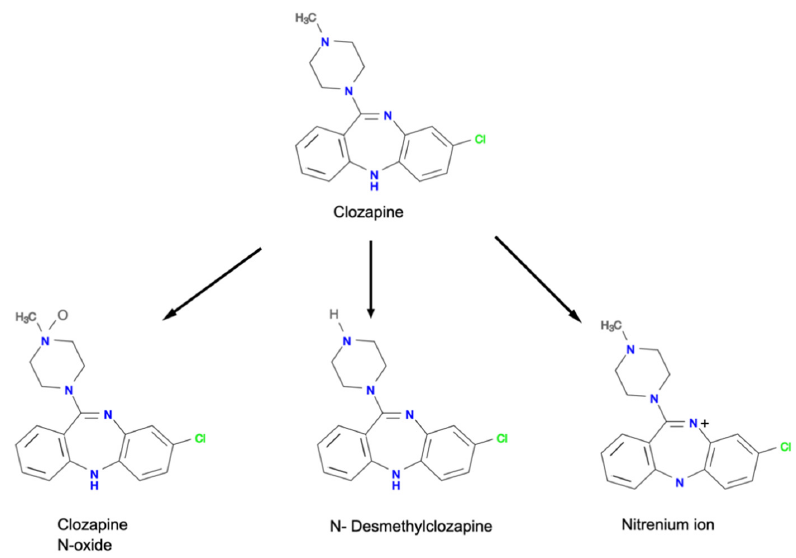
Figure 3. Chemical structures of clozapine and nitrenium ion (adapted from Pirmohamed and Park